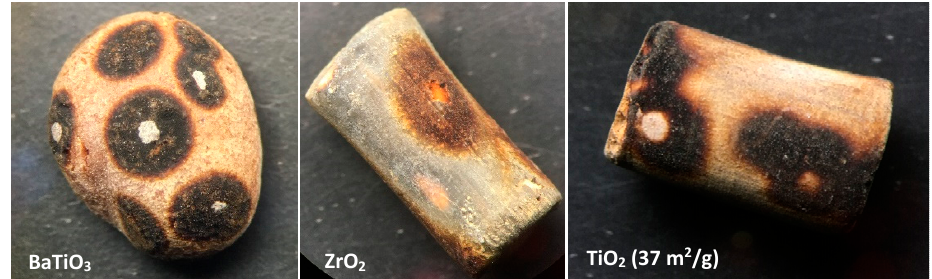
Figure 6. Photographs of surface of various packing materials with circular patterns of solid deposits (magnification 250×).